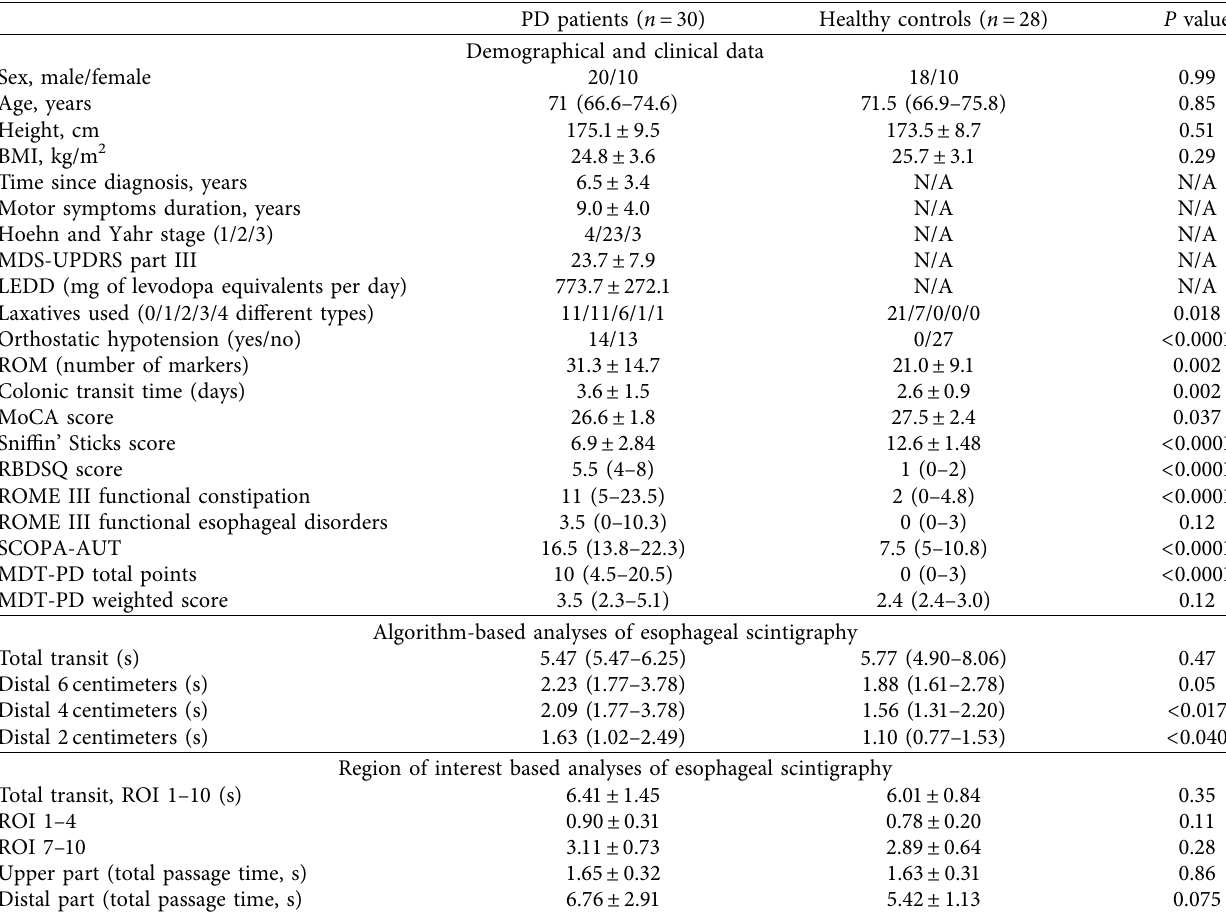
Table 1: Demographic, clinical, and scintigraphy data from patients with Parkinson disease (PD) and healthy controls (HC).